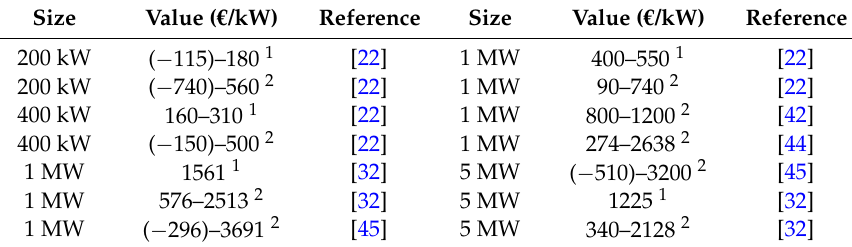
Table 1. Economic analysis of industrial PV